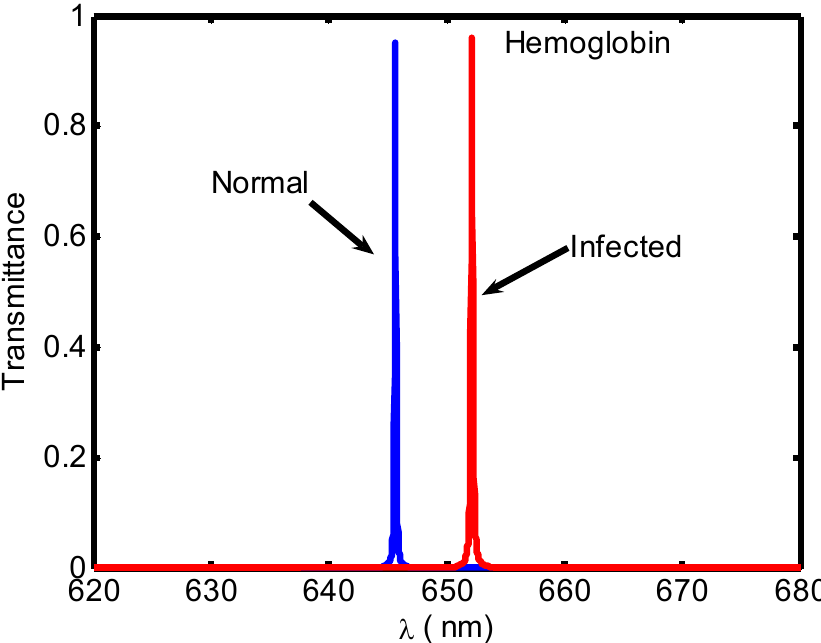
Figure 5. The transmission spectra showing two defect modes inside the PBG of the proposed 1D biophotonic sensor loaded with normal and infected samples containing the hemoglobin component of blood, having a cavity thickness 200 nm at normal incidence.